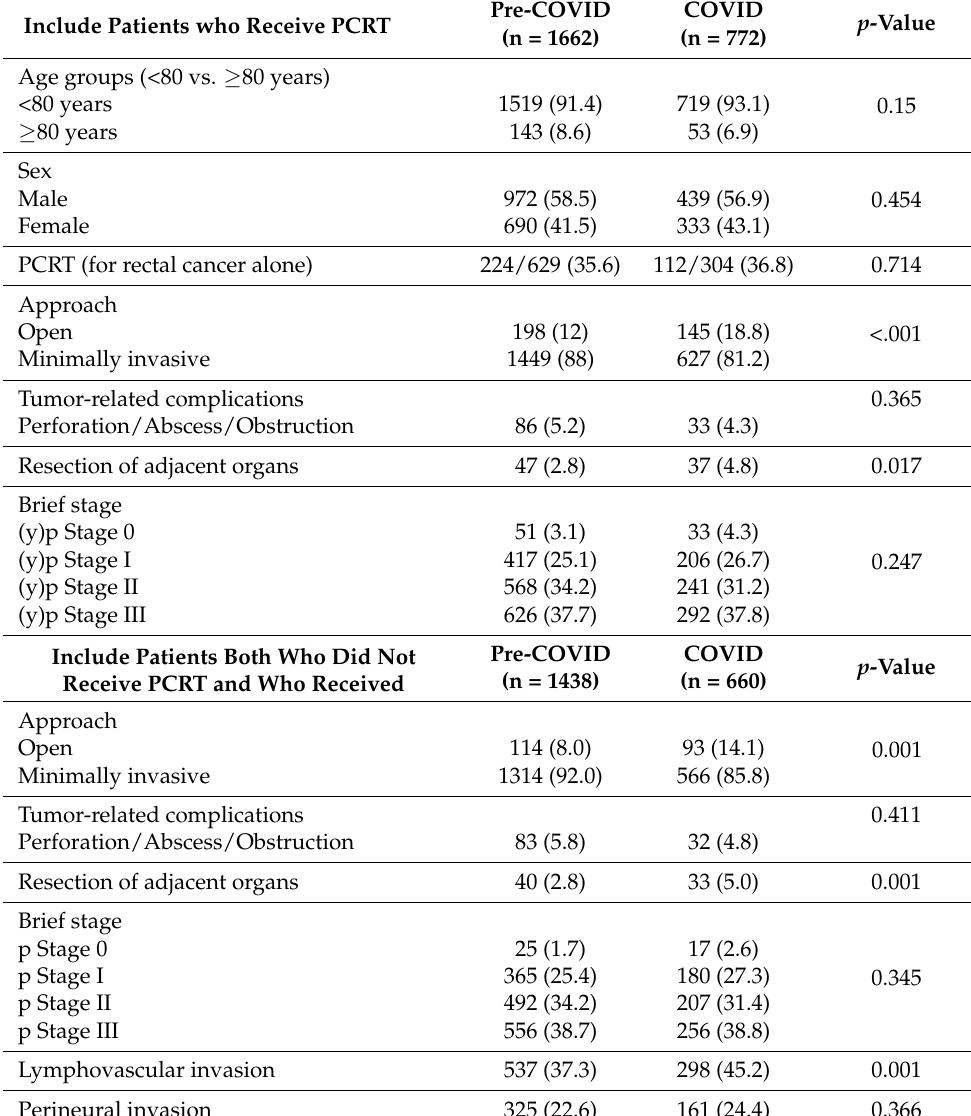
Table 2. Characteristics of patients who underwent curative radical resection for stage 1–3 colorectal cancer during the pre-COVID and COVID